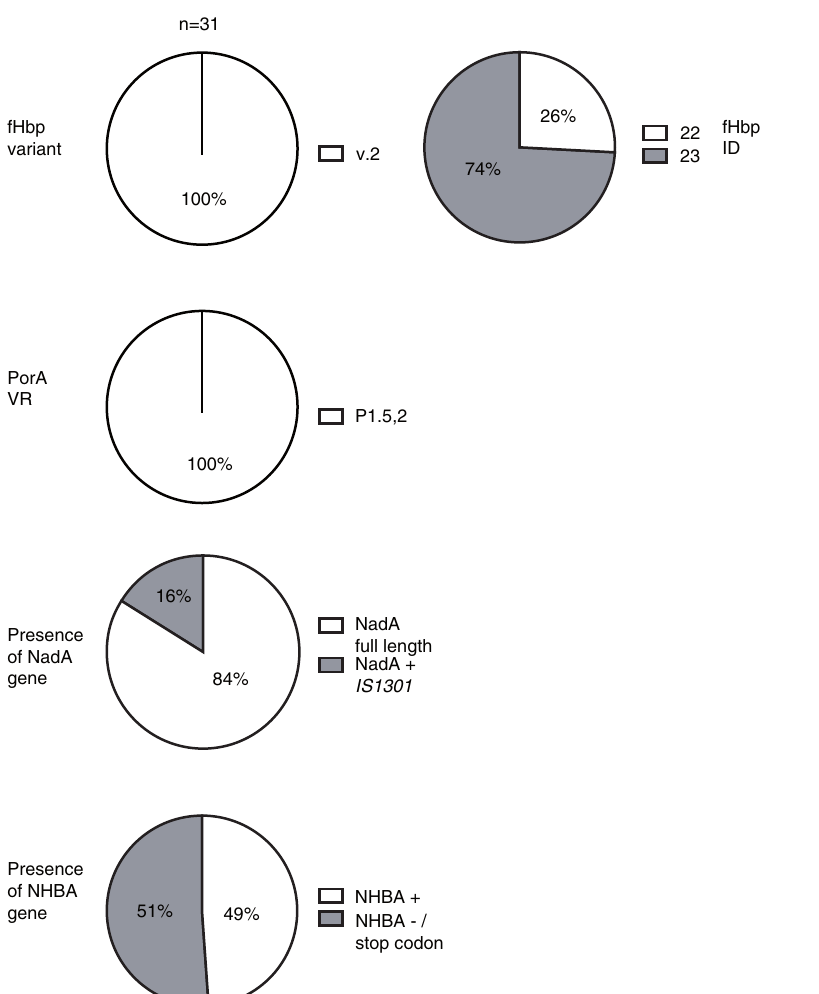
Figure 1. FHbp, PorA, NadA and NHBA typing analysis of meningococcal serogroup W isolates from Ghana and Burkina Faso. The fHbp variant group is designated according to the classification proposed by Masignani et al. 17 . FHbp sequence ID, PorA subtype, nadA and nhbA allele were determined by sequence query on http://pubmlst.org/neisseria. Each isolate was typed by PCR amplification of each respective gene and sequence analysis using bioinformatics software Simmonics, Mega 5 and Chromas. NadA + IS1301: Strains with NadA encoding gene containing insertion sequence IS1301 . NHBA-/stop codon: Strains lacking the NHBA encoding gene or having nhbA with stop codon.